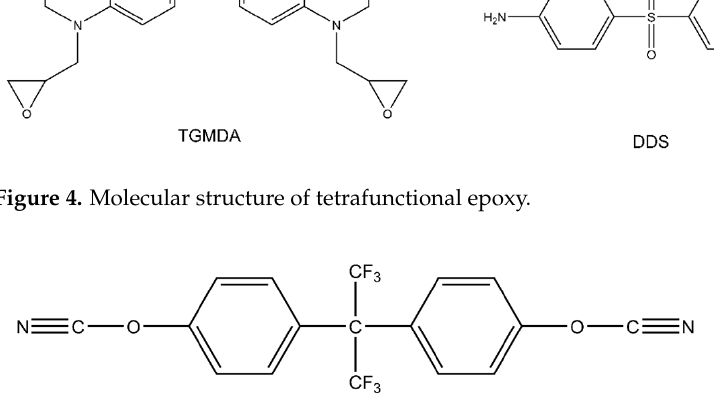
Figure 4. Molecular structure of tetrafunctional epoxy.